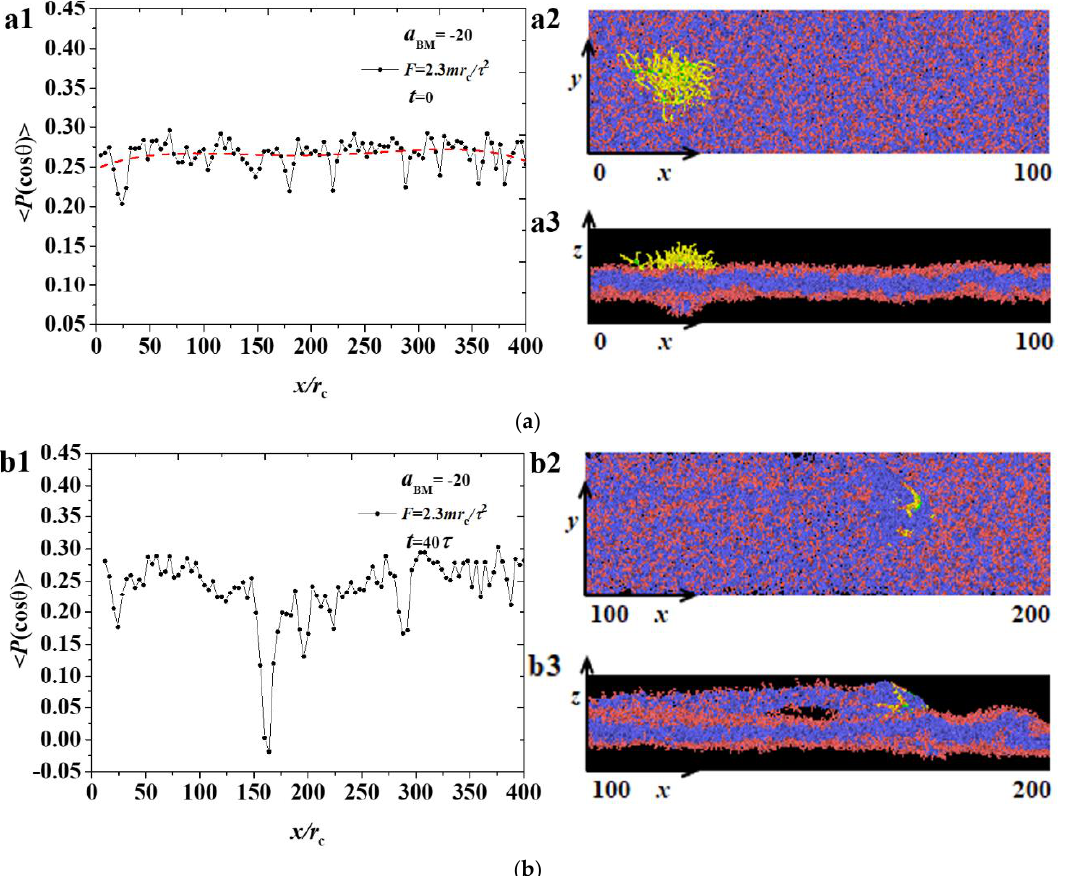
Figure 9. The distribution of order parameters P ( cos θ ) for the phospholipid membrane in the strong adsorption cases of a BM = − 20 and F = 1.7 mr c / τ 2 , where the membrane structures are also displayed. Three time stages, ( a ) t = 0 τ , ( b ) t = 40 τ , and ( c ) t = 110 τ , are demonstrated.